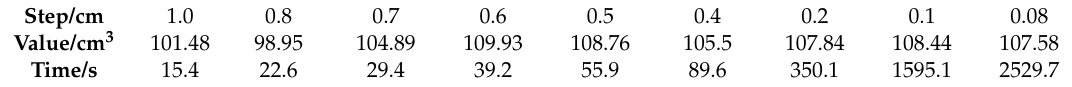
Figure 12. Trends of the obtained value and time cost based on different sampling steps. ( a ) Relationship between step length and accuracy; ( b ) Relationship between step length and computation speed. Table 3. Partial measurement values and processing time for different sampling steps.